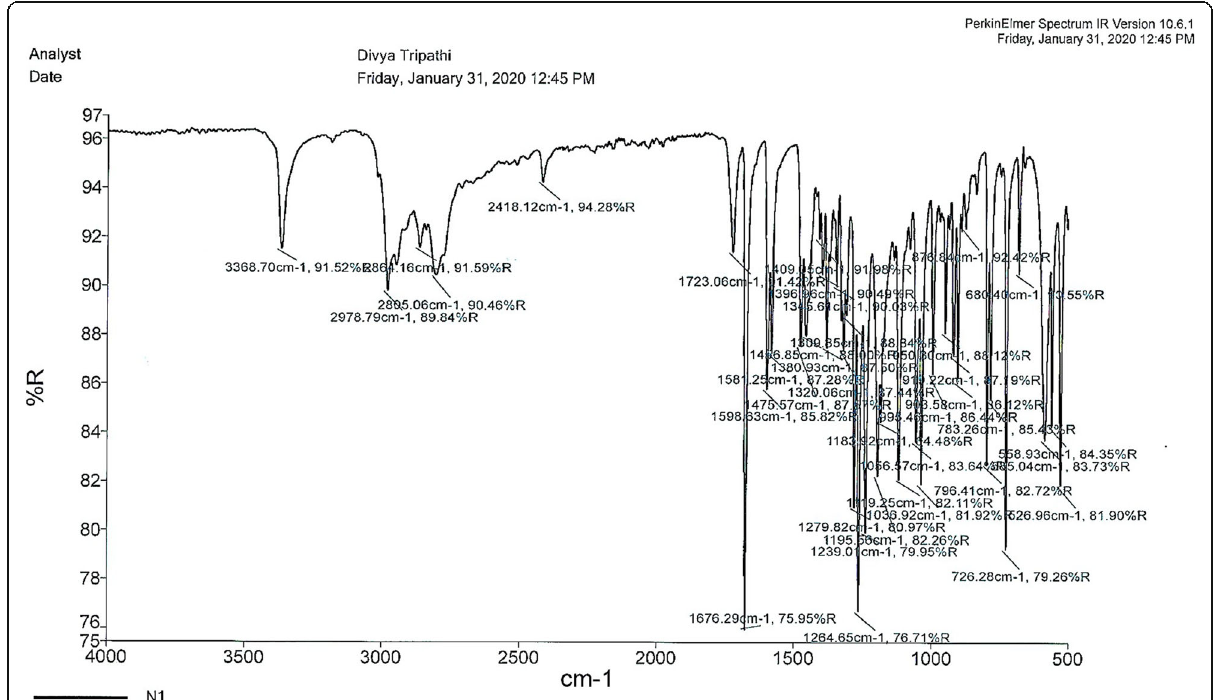
Fig. 3 FTIR spectra of the drug